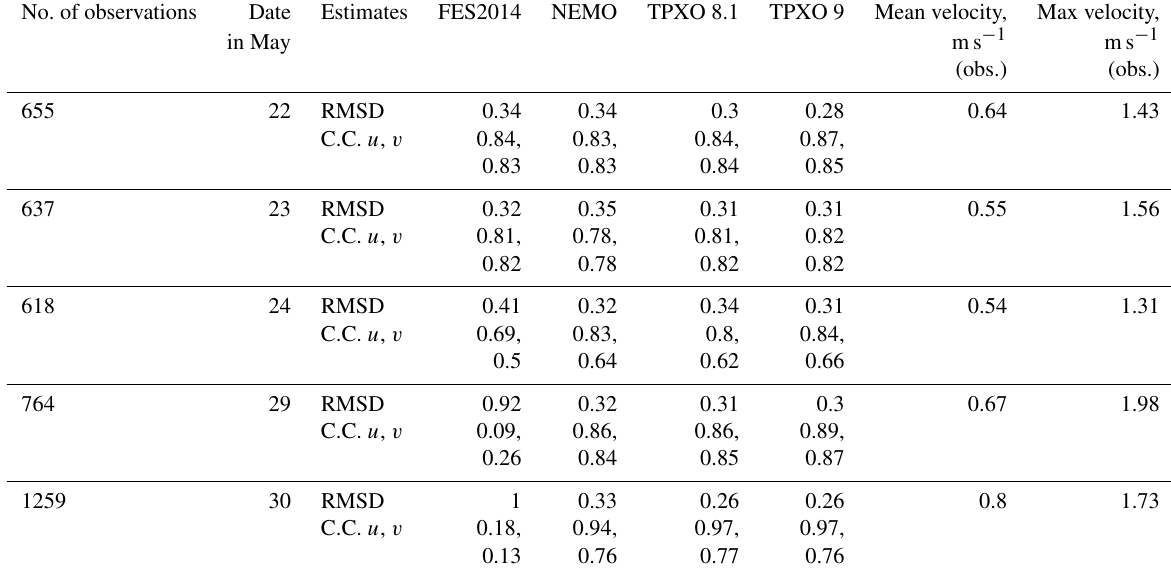
Table 2. The intercomparison of the observed and simulated velocities based on different open-boundary conditions in the area of Lister Deep. The table presents root mean square deviation (RMSD, ms − 1 ) and correlation coefficients (C.C.) for u and v velocity components. The results are given for the simulations performed on the curvilinear